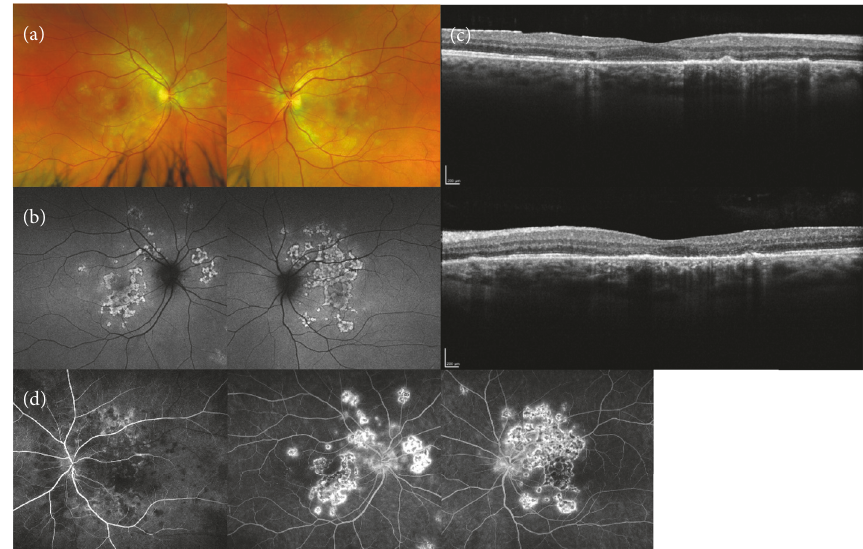
Figure 1: Images taken 3 days after onset of symptoms. Fundus photo, yellowish white subretinal placoid lesions (a). FAF, placoid lesions with central hypoautofluorescence with hyperautofluorescentedges (b). OCT Fovea, top: OD and bottom: OS. RPE and ellipsoid zone attenuation of placoid lesions. Subretinal hyperreflective material (c). FA, left: early phase OS. Central and right: late phase OD and OS. Early blocking with late staining